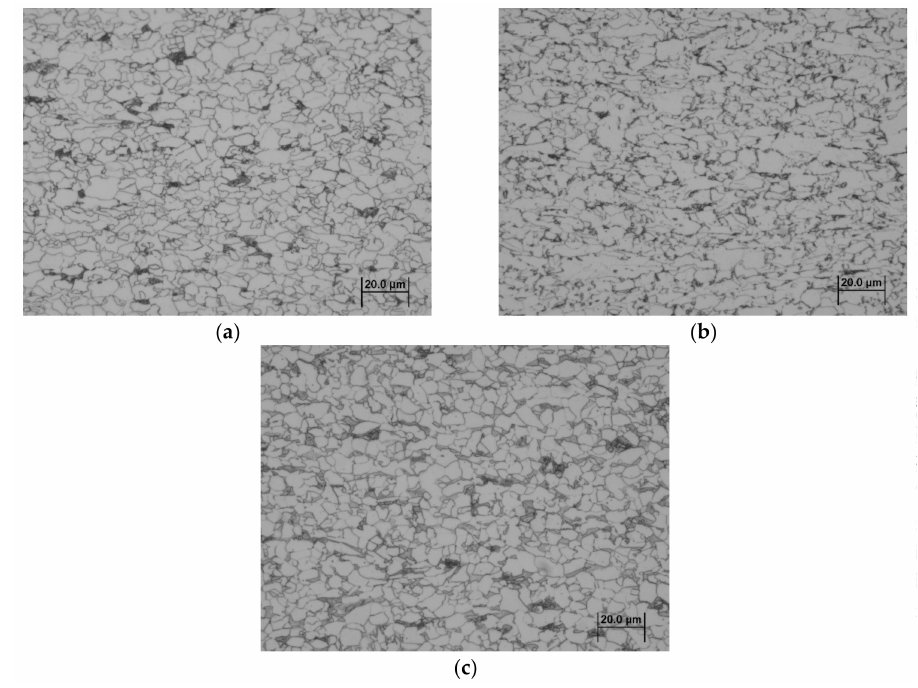
Figure 2. The microstructure of the as-received steels: ( a ) A—X60; ( b ) B—S460MC; ( c ) C—DP600.